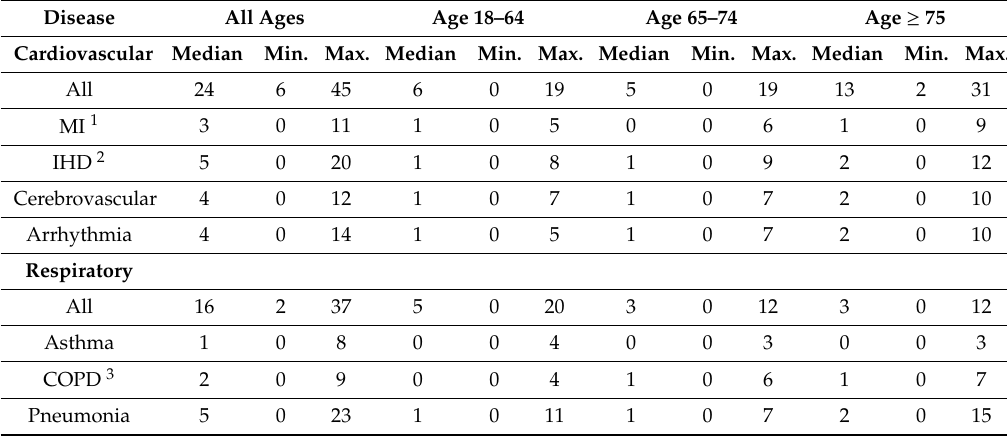
Table 1. Daily number of hospital admissions for cardiorespiratory diseases during summer months (June–August) in the Helsinki metropolitan area, Finland, 2001–2017. Disease